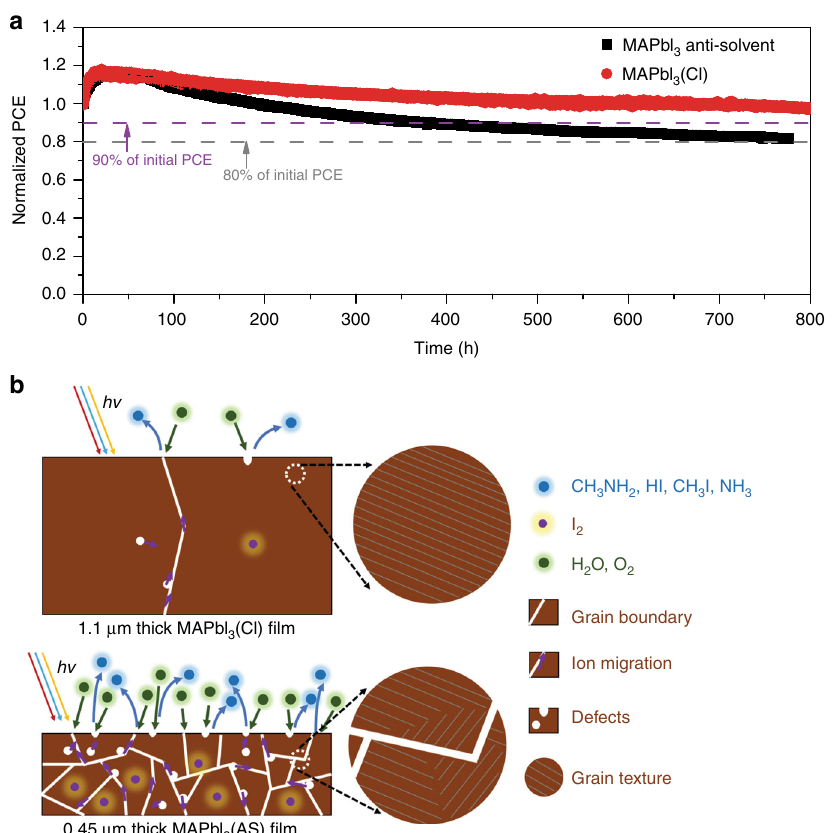
Fig. 6 Device stability and fi lm stability. a Operational stability of un-encapsulated PSCs based on 1.1 μ m thick MAPbI 3 (Cl) fi lms and perovskite fi lms deposited via the antisolvent method examined under continuous full-sun illumination in dry nitrogen atmosphere. b Factors in fl uence fi lm stability of perovskites